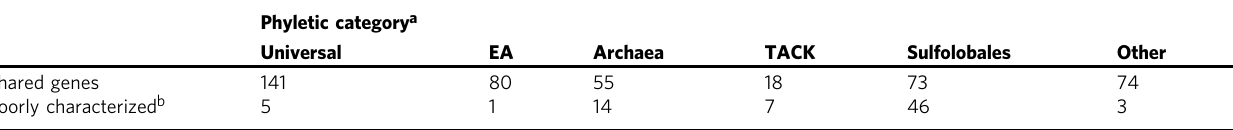
Table 2 Number of S. islandicus essential genes shared with 168 full genome sequences spanning the tree of life